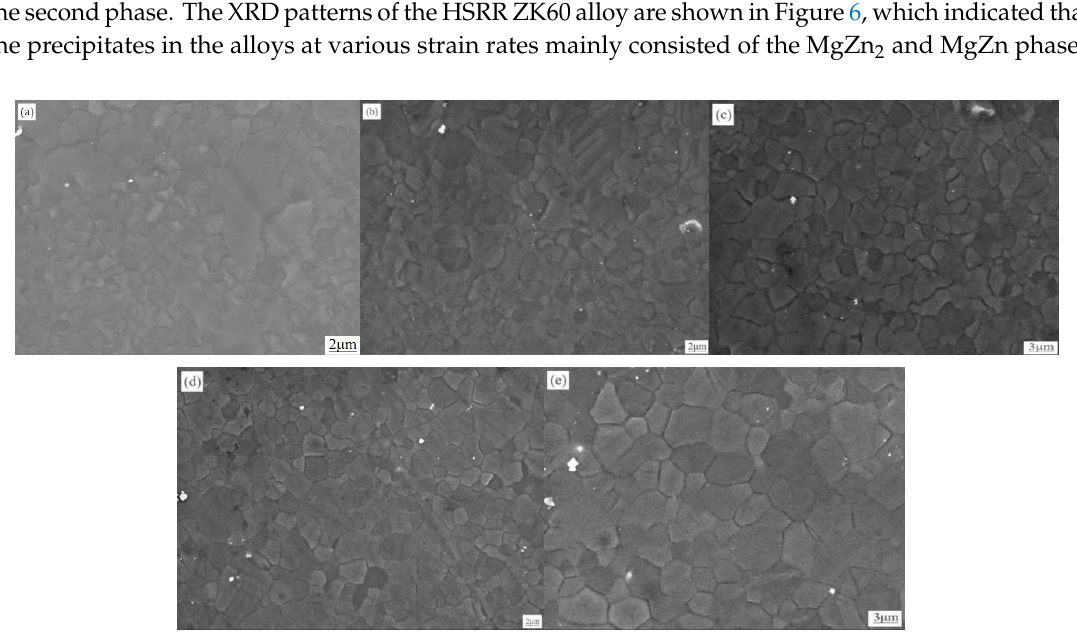
Figure 5. SEM images of the ZK60 magnesium alloy after HSRR under different strain rates. ( a ) 5 s −1 ( b ) 10 s −1 ( c ) 15 s −1 ( d ) 20 s −1 ( e ) 25 s −1 .